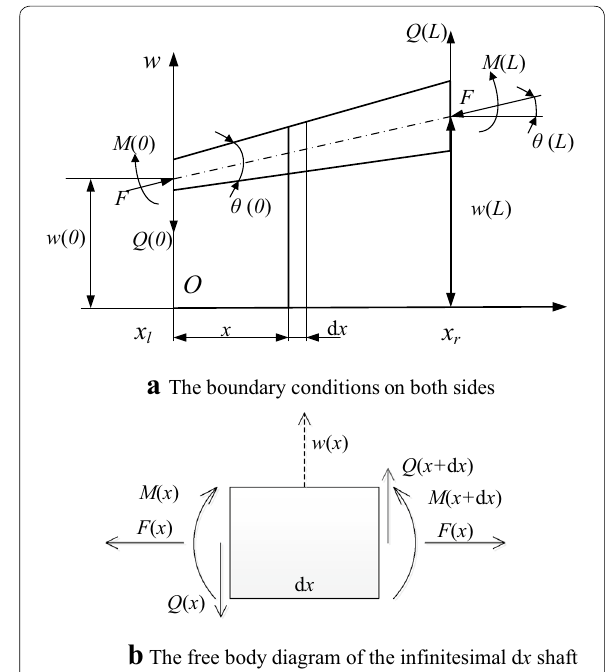
Figure 2 Free body diagram of a non-uniform